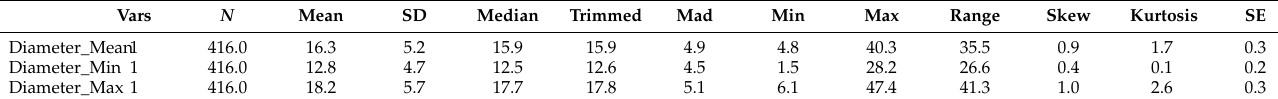
Table 1. Summary of descriptive statistics of the AuNPs size of the washed sample at pH 6 (the pH was adjusted prior to the preparation of the AuNPs) shown in Figures 4B and 5. The table summarizes the standard output of the R function describe see details in Mangiafico [34,35]. Vars = number of variables in a data set; N = size of a data set; mean = arithmetic mean; SD = standard deviation; median = the mean value in a data set; trimmed = mean trimmed to 60%, 20% off each side; mad = the absolute deviation of the median; min = minimum value in a data set; max = maximum value in a data set; skew = skewness, the degree of asymmetry in a data set; kurtosis = a measure of extreme outliers; SE = standard error of the mean.